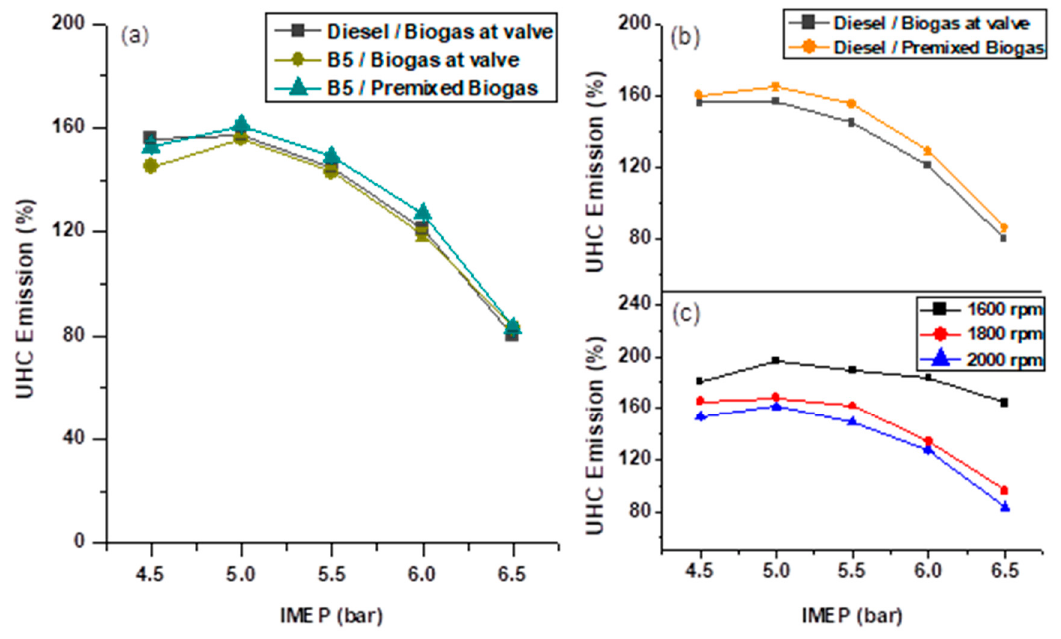
Figure 17. Engine-out UHC emission for ( a ) B5/biogas RCCI for premixed and port injection at the valve, ( b ) diesel/biogas in a premixed and port injection at the valve, and ( c ) B5 and premixed biogas RCCI combustion at various engine speeds.